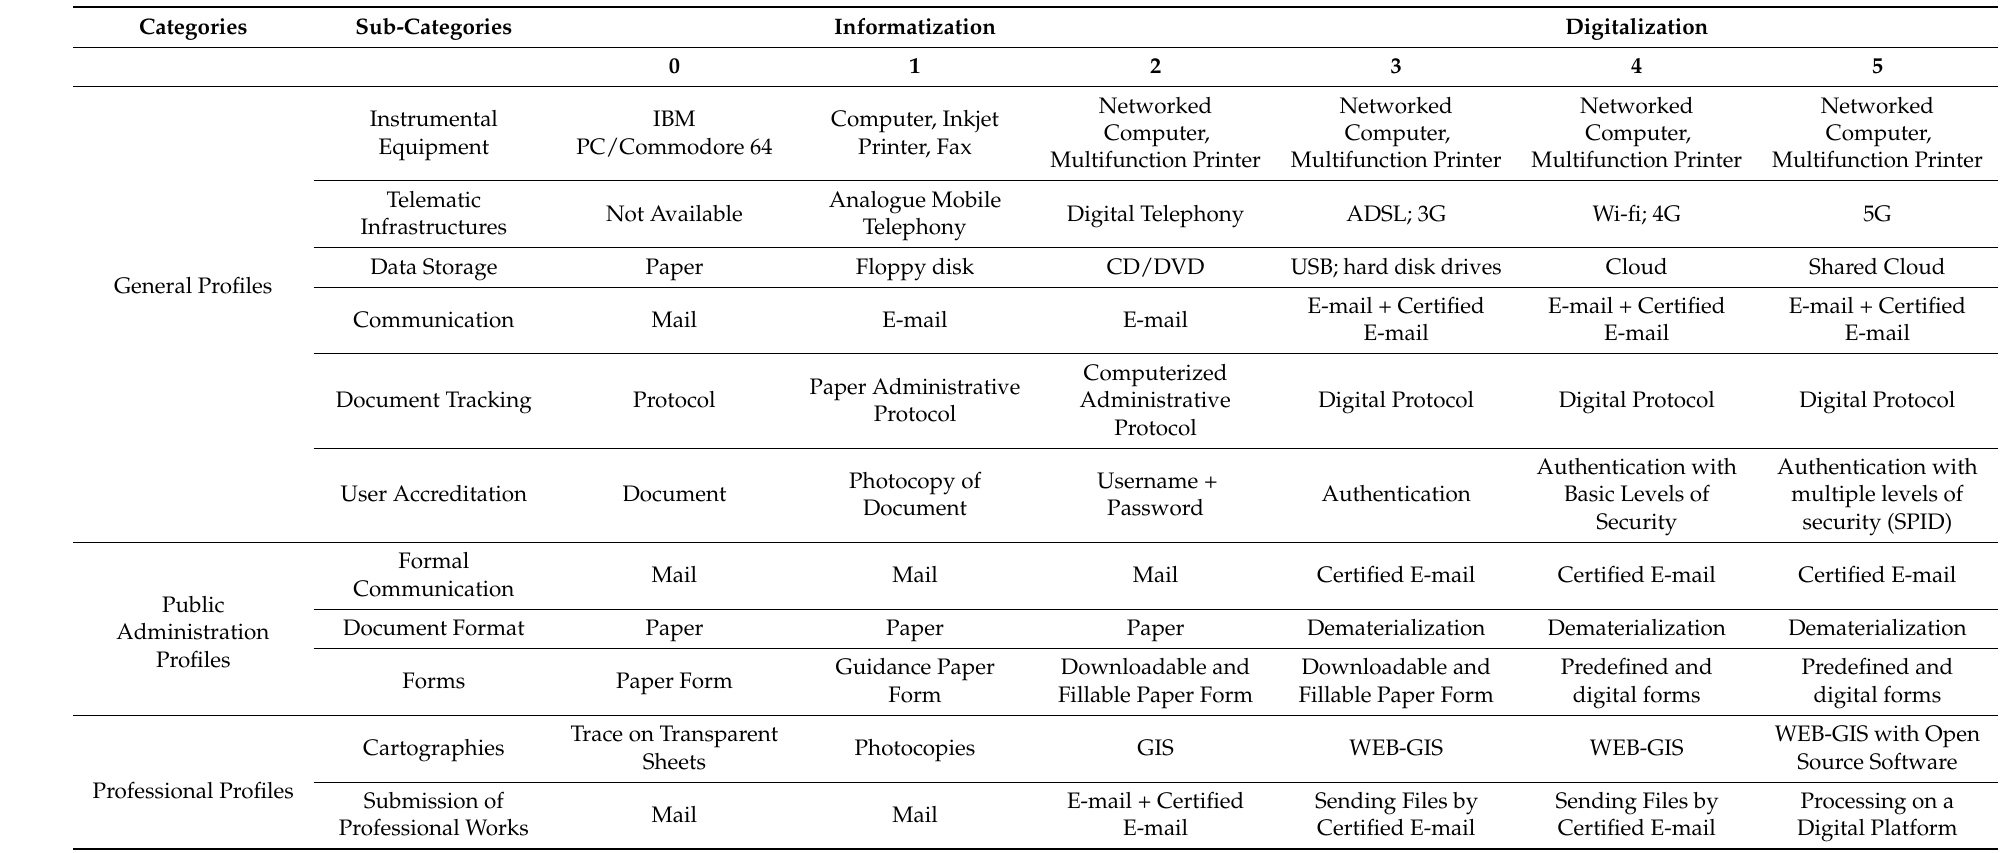
Table 3. Matrix of the evolution of IT-digital